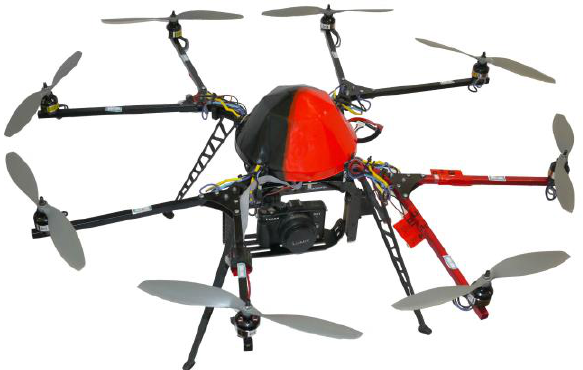
Figure 3. MK-Okto by Hisystems GmbH mounted with Lumix DMC GF3 consumer